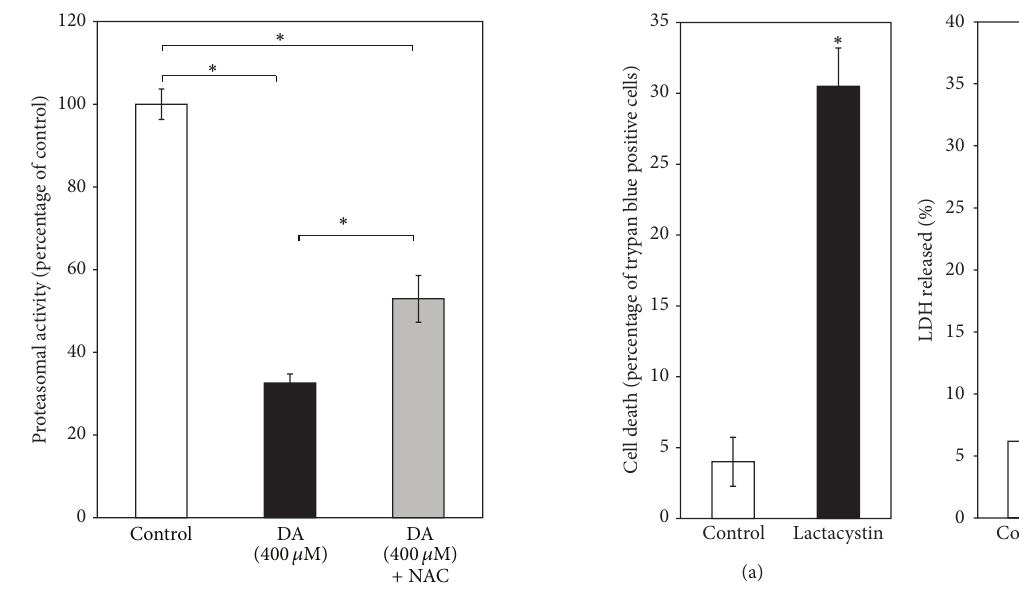
Figure 4: Effect of DA on proteasomal activity in SH-SY5Y cells. Proteasomal activity was measured in SH-SY5Y cells incubated without or with DA (400 𝜇 M) for 24h in the presence or absence of NAC (2.5 mM) as detailed in Section 3. Values (expressed as percentage of the control) are the means ± SD of five observations. Statistically significant differences exist ( 𝐹 (2,12) = 356.38, 𝑃 < 0.001 ) between the groups as shown by asterisks ( ∗ ).